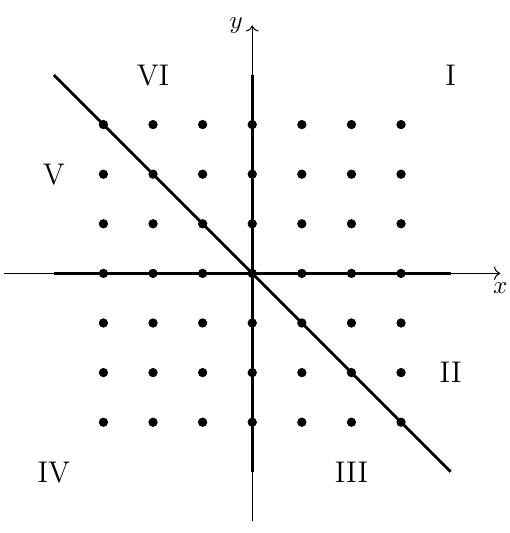
Figure 2 . Hyperplanes superimposed on T 2 charge